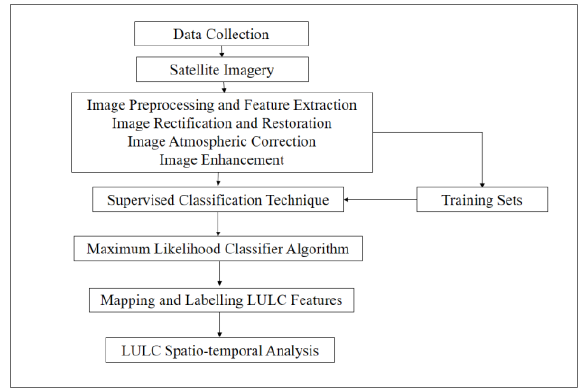
Figure 3. Working Methodology- Land use/ Land Cover